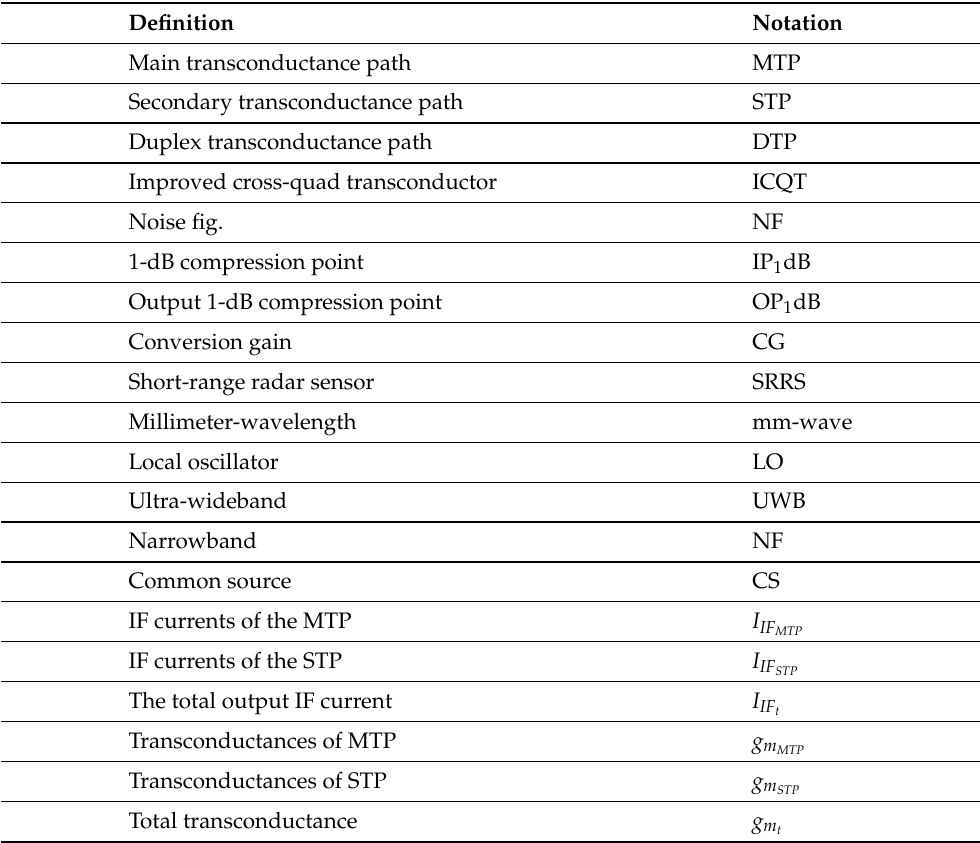
Table 2. Notations used in the proposed